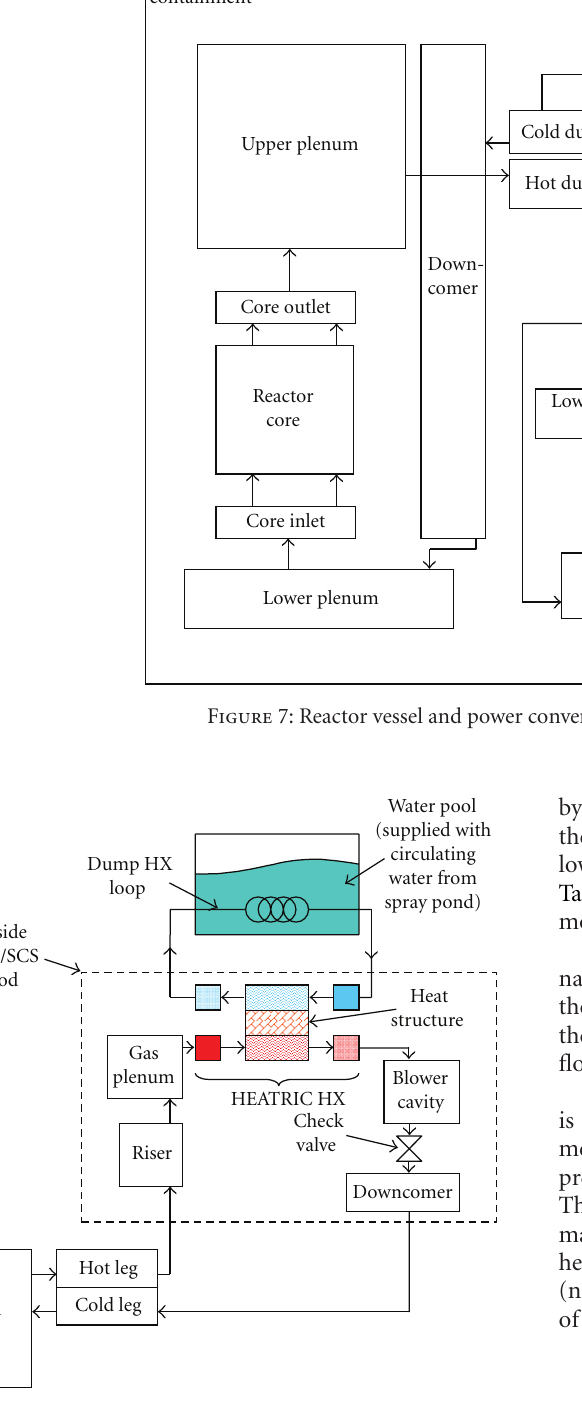
during the first 24 hour after a reactor shutdown. Details of the volume representation of the ECS are shown in Figure